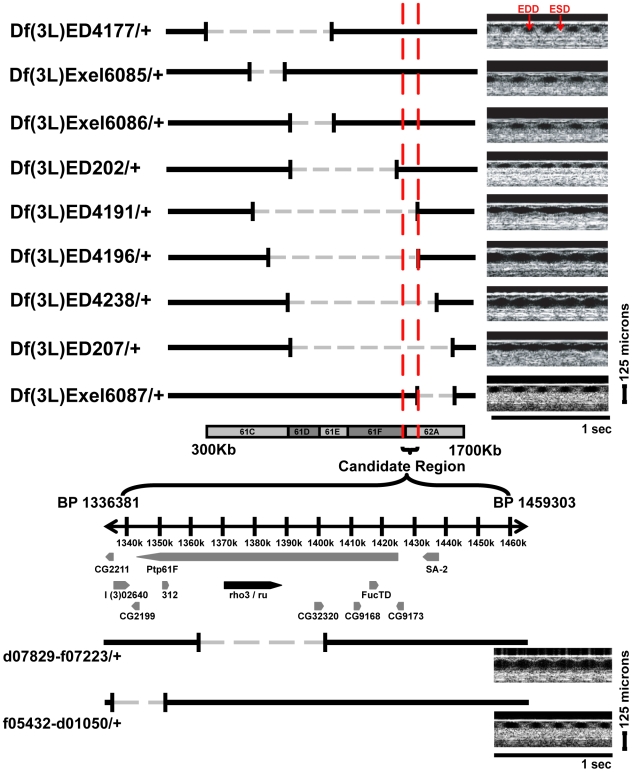
Schematic representation of the candidate region of chromosome 3L.Each line represents the region of the genome that is deleted in gray with the DrosDel or Exelixis stock designation to the left of the line. Representative OCT m-modes corresponding to each strain are shown to the right. A 125 micron standard is shown. Inclusion of regions that correspond to dilated cardiac phenotype and exclusion of regions that had normal cardiac function is represented by the red lines and narrows the interval to ∼122 kb of genomic DNA. The genes encoded within the candidate region are shown below with ru (rho3) represented in black. The d07829-f07223/+ and f05432-d01050/+ custom genomic deletions with representative OCT m-modes are shown below.